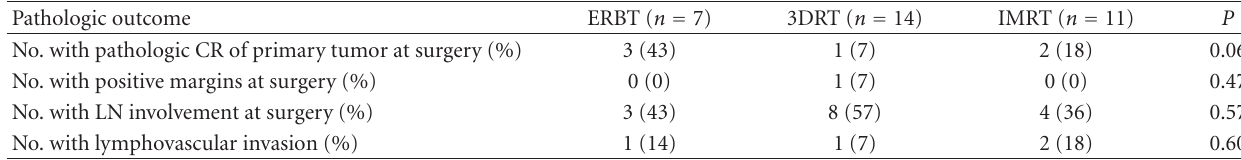
Table 4: Pathologic outcomes broken down by EBT, 3DRT, and IMRT groups with statistical comparison. EBT: endorectal brachytherapy; 3DRT: 3D conformal radiotherapy; IMRT: intensity-modulated radiotherapy; RT: radiotherapy; CR: complete response; LN: lymph nodes. Pathologic